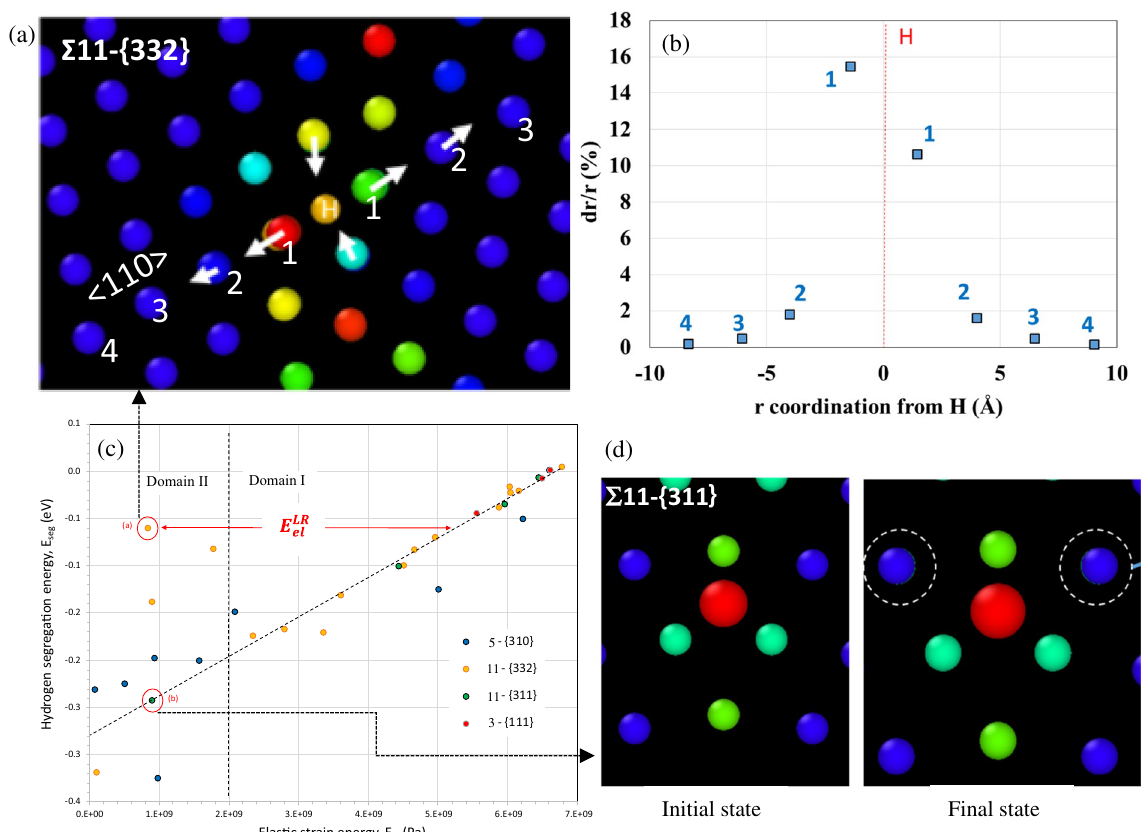
Figure 5. The loss of the linear relation between the segregation energy, E seg and the elastic strain energy E el (c) is directly a consequence of the anisotropy of the displacement field and “long range” elastic distortion. ( a ) An illustration of the anisotropy of the displacement field along 〈 110 〉 near a Σ11-{332}. ( b ) The relative radial displacement dr/r along 〈 110 〉 as a function of the r coordination from H (corresponding to the Σ11-{332} illustrated in ( a )). ( d ) Moderate quasi-isotropic short range displacement for a position of hydrogen which respects the linear relation of E seg versus E el (see picture ( c ), GB Σ11-{311}).